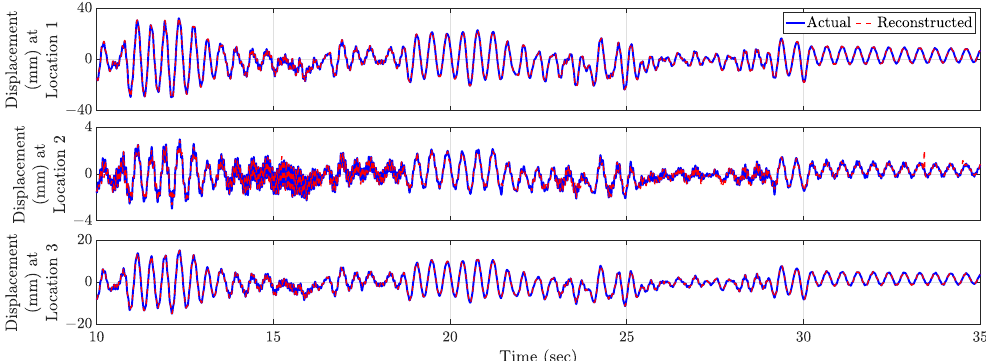
Figure 16. Comparison of actual and reconstructed time history response at Locations 1 (‘cyan diamond’), 2 (‘green square’), and 3 (‘magenta star’) in Figure